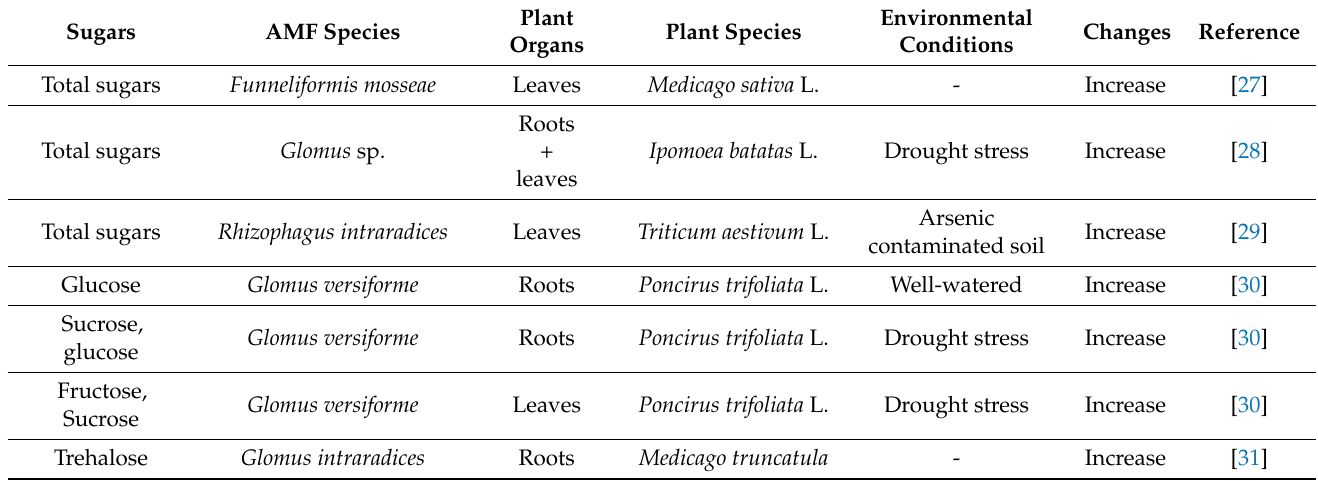
Table 1. Changes of sugar content in different plant species influenced by AMF